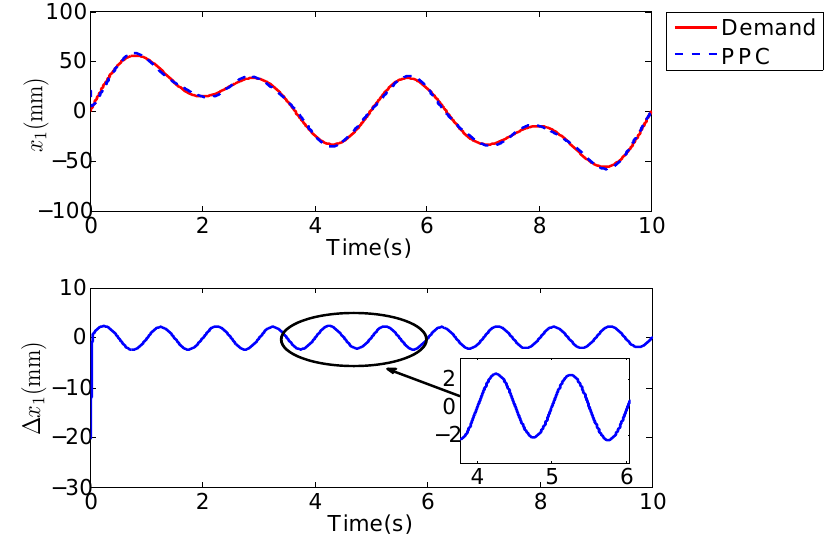
Figure 8. The cylinder position responses x 1 by prescribed performance constraint controller with hydraulic parametric uncertainties and the external load, the demand y d = 25 ( sin ( 0.8 π t ) + sin ( 0.4 π t ) + sin ( 0.2 π t )) mm.